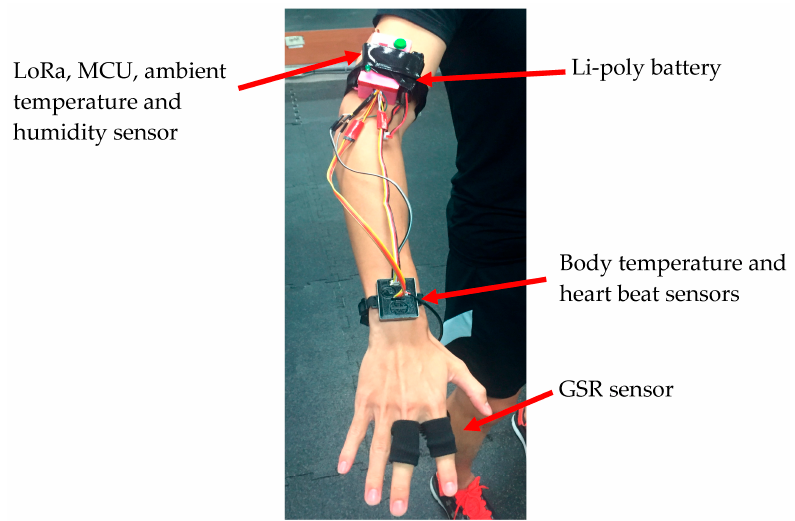
Figure 4. The WHDD attached to the arm of a runner. Figure 5 represents the configuration of individual sensors and components in the